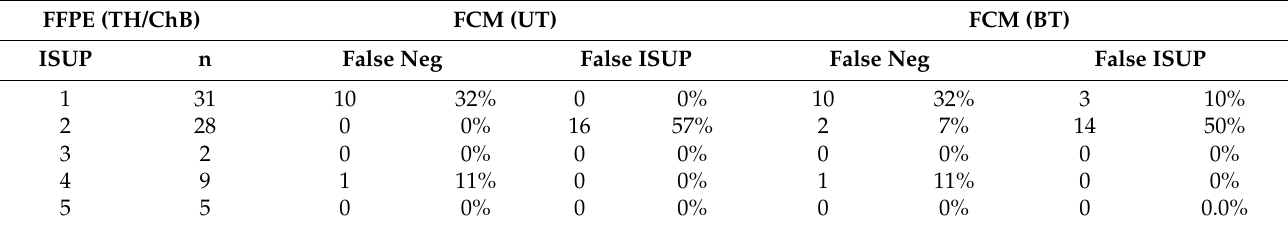
Table 5. Limitations of tumor diagnoses and ISUP grading in FCM